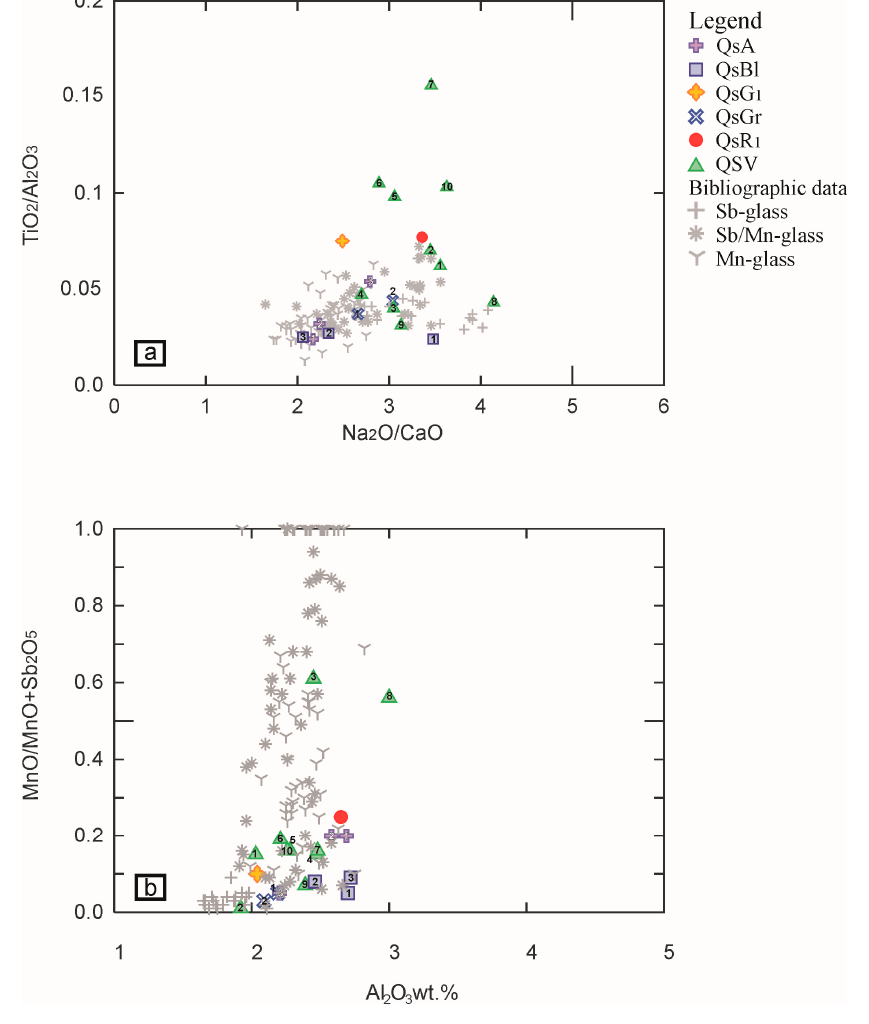
Figure 5. Binary diagrams ( a ) Na 2 O/CaO vs. TiO 2 /Al 2 O 3 ; ( b ) Al 2 O 3 vs. MnO/(MnO + Sb 2 O 5 ). In these legend refer to the various types of tesserae, while the numbers inside the symbols in the diagrams are associated with the individual sample